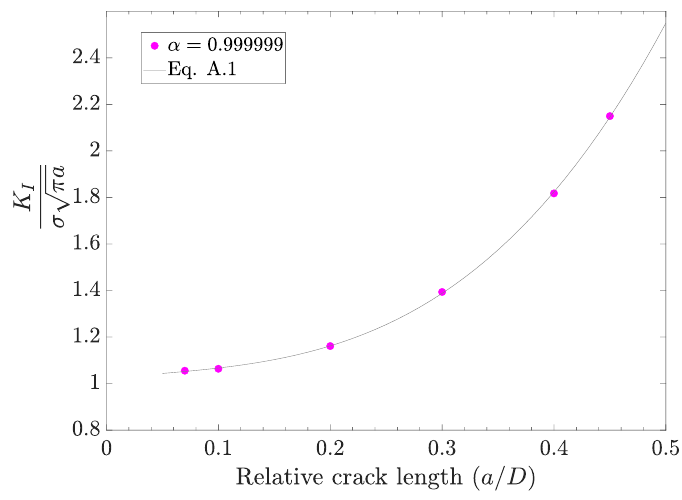
Figure A2. Non-dimensional SIF of an isotropic free fibre resulting from a computational model of the isolated fibre (line) and with embedding material of nearly zero stiffness